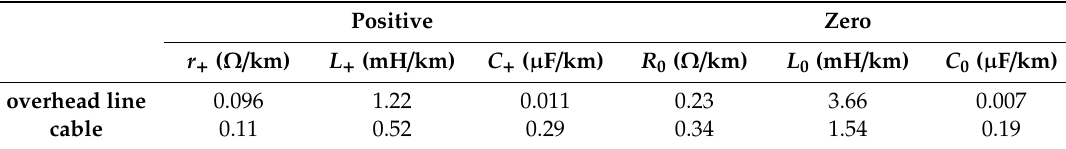
Table 3. Typical sequence parameters of distribution lines.